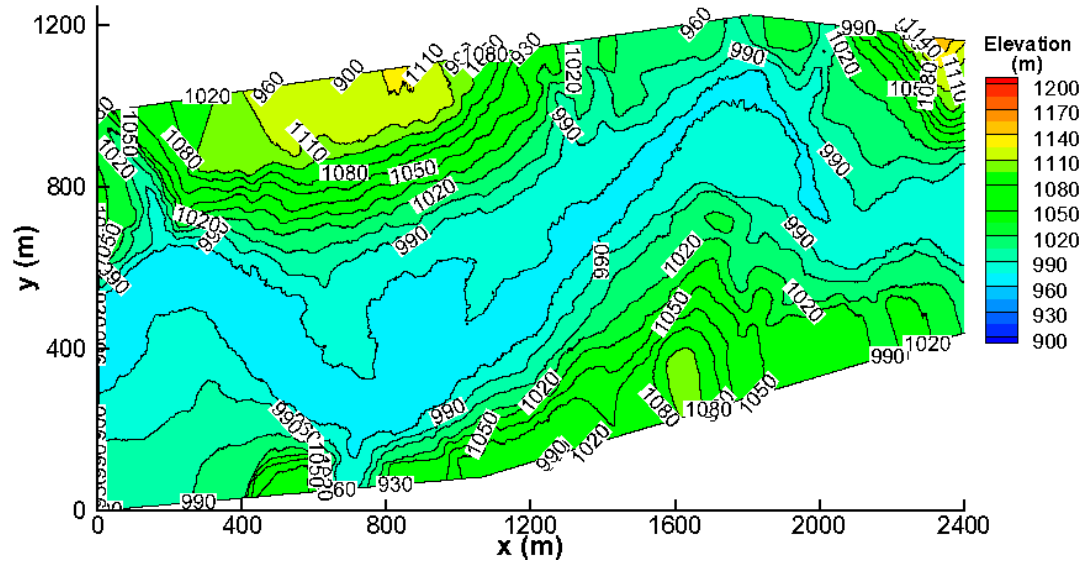
Figure 3. Topography of the study area (x and y are local coordinates).